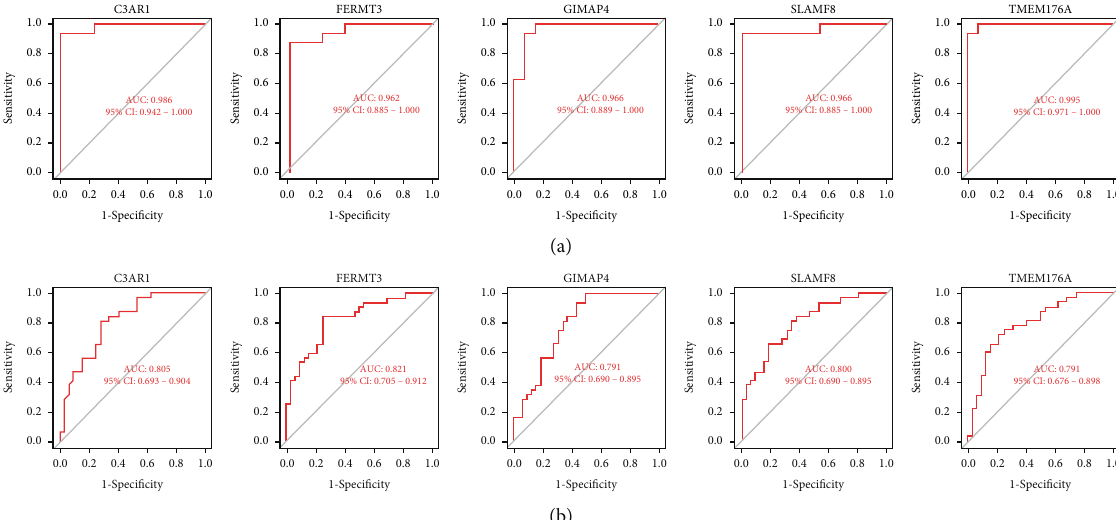
Figure 7: Validating the diagnostic performance of the hub genes. (a) Validating the diagnostic performance of the hub genes in the GSE28829 dataset. ROC curves and AUC values were used for assessing the ability to di ff erentiate between the early- and advanced-stage carotid atherosclerotic plaques, with high speci fi city and sensitivity. (b) Validating the diagnostic e ffi ciency of the hub genes in the GSE43292 dataset. Similar results were noted as those in the GSE28829 dataset. These fi ndings prove that the 5 hub genes displayed an excellent diagnostic e ffi ciency in the advanced-stage carotid atherosclerotic plaques. ROC: Receiver Operating Characteristic; AUC: Area Under the